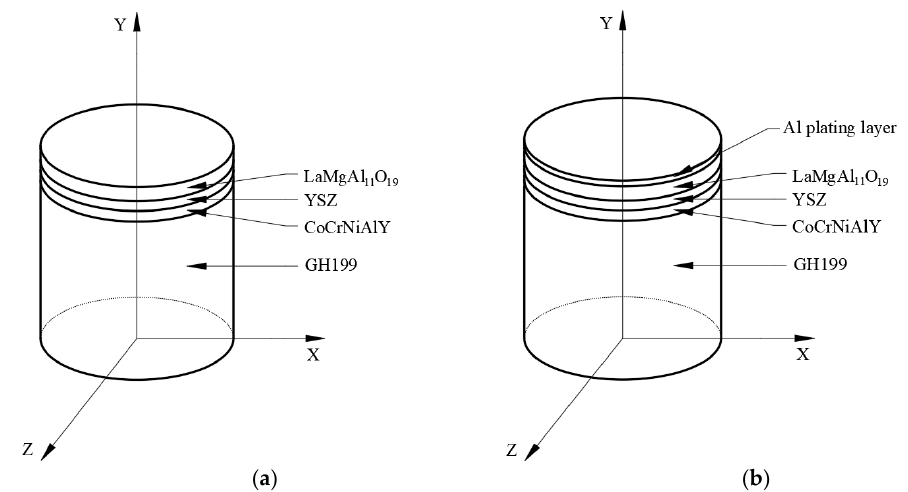
Figure 1. Three-dimensional finite element physical model: ( a ) M1, ( b ) M2.